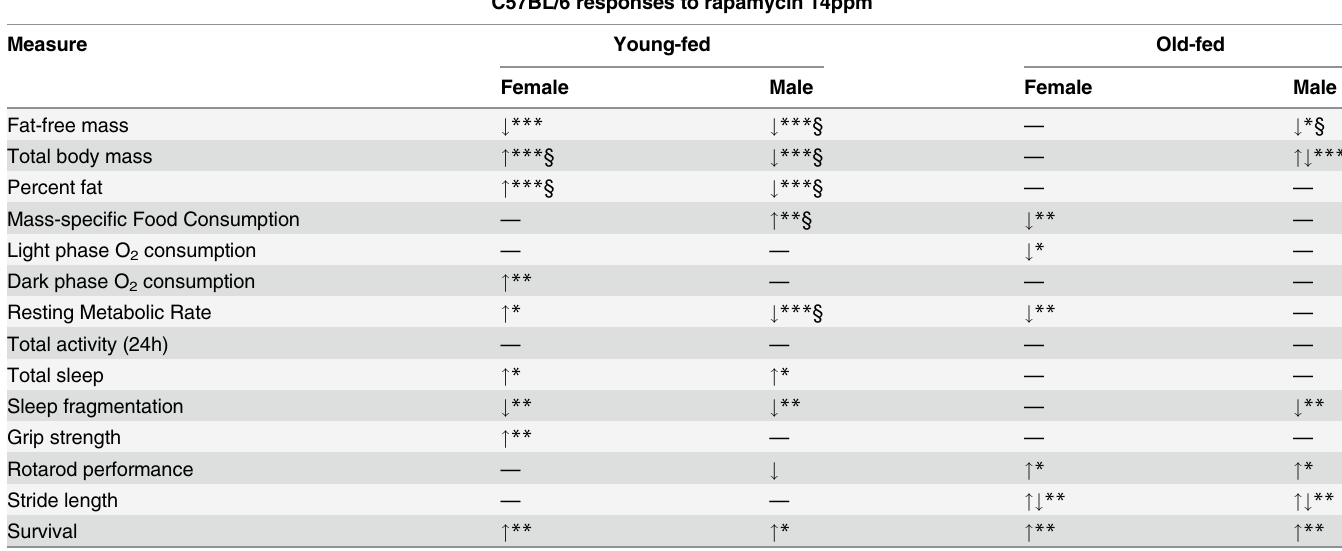
Table 1. Differences in two rapamycin